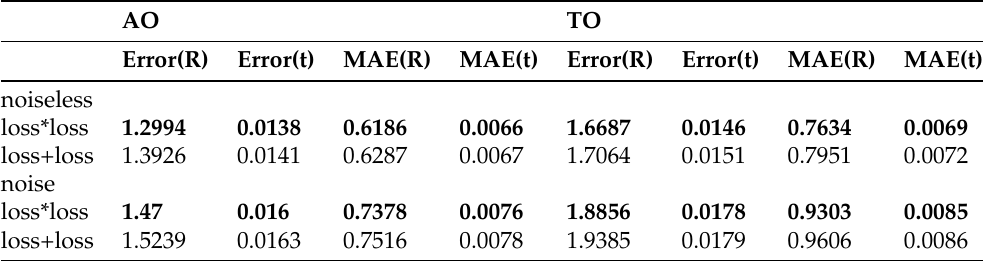
Table 1. Results of metrics with different loss functions training for 300 epochs.